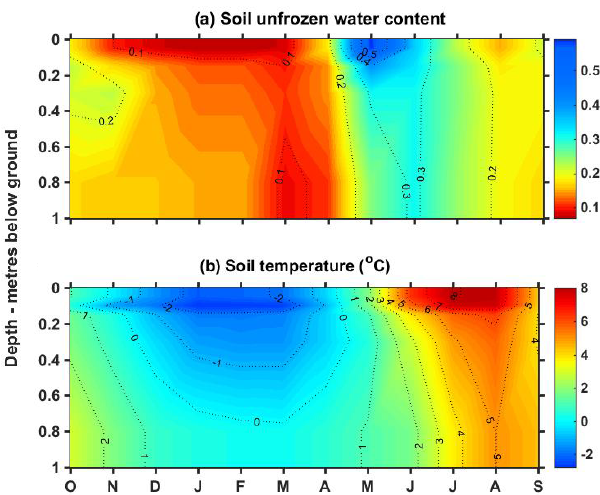
Figure 6. Water year cycle of (a) the unfrozen water content of soil and (b) soil temperature at the shrub tundra site in Wolf Creek Research Basin at depths of 0 to 1m below ground